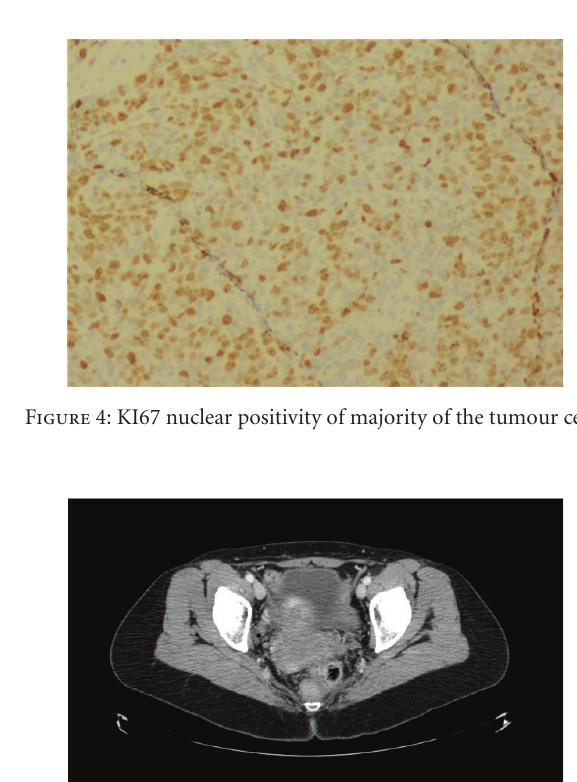
Figure 5: CT scan